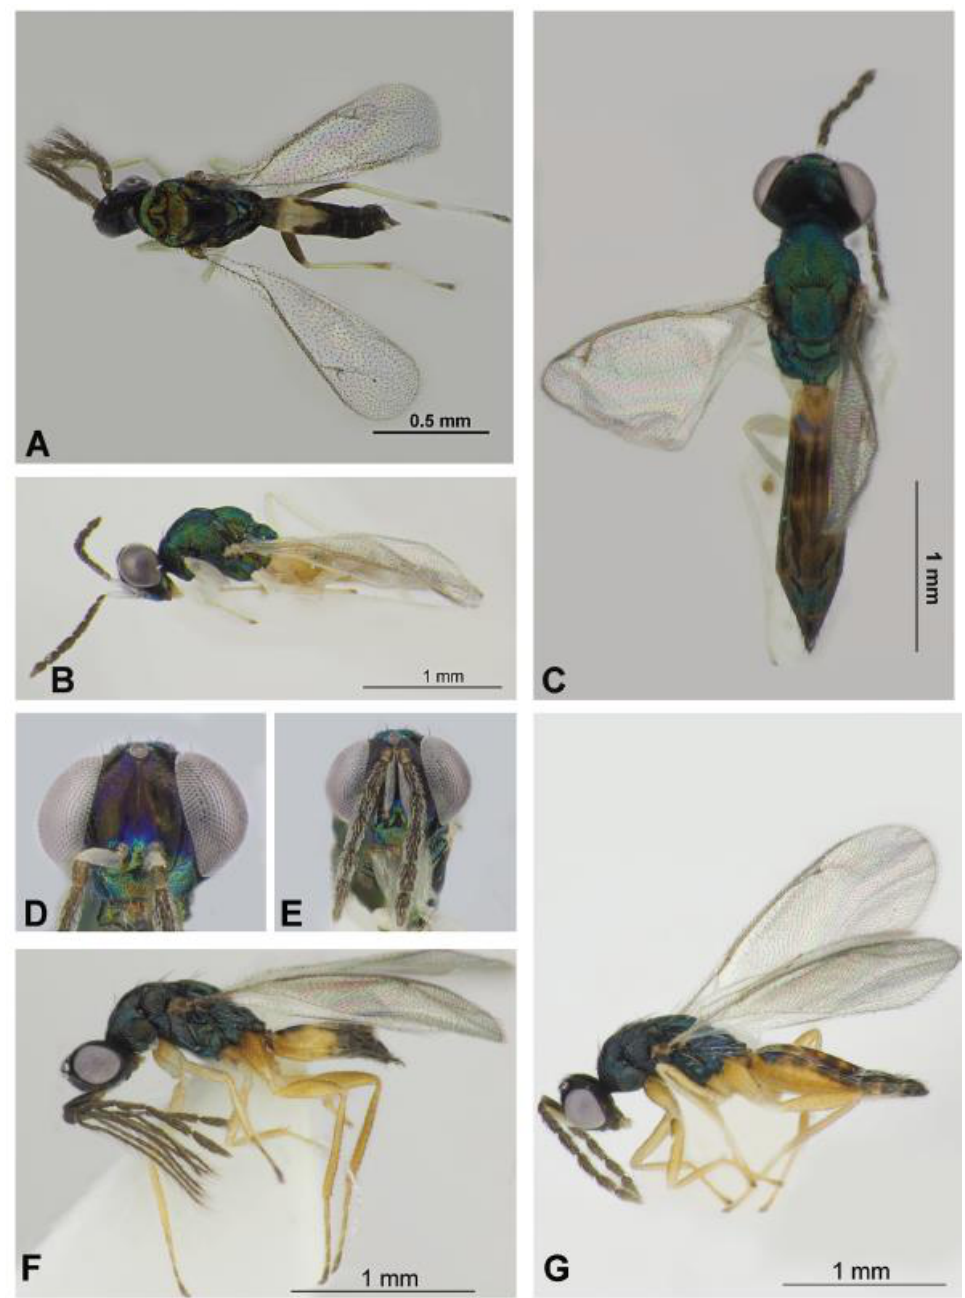
Figure 6. Eulophinae (females, males): Sympiesis gordius (Walker, 1839) (male) ( A ), Sympiesis laevifrons Kamijo, 1965 (female) ( B – E ), Pnigalio soemius (Walker, 1839) (male and female) ( F , G ). Habitus in dorsal view ( A , C ) and lateral view ( B , F , G ), face and antennae in frontal view ( D , E ). Hosts. Solitary ectoparasitoid leaf miner larvae belonging to the orders Lepidoptera Pnigalio (Gracillariidae, Lyonetiidae, Nepticulidae, Yponomeutidae), Coleoptera (Curculionidae) and Diptera (Agromyzidae, Cecidomyiidae) [69,85].